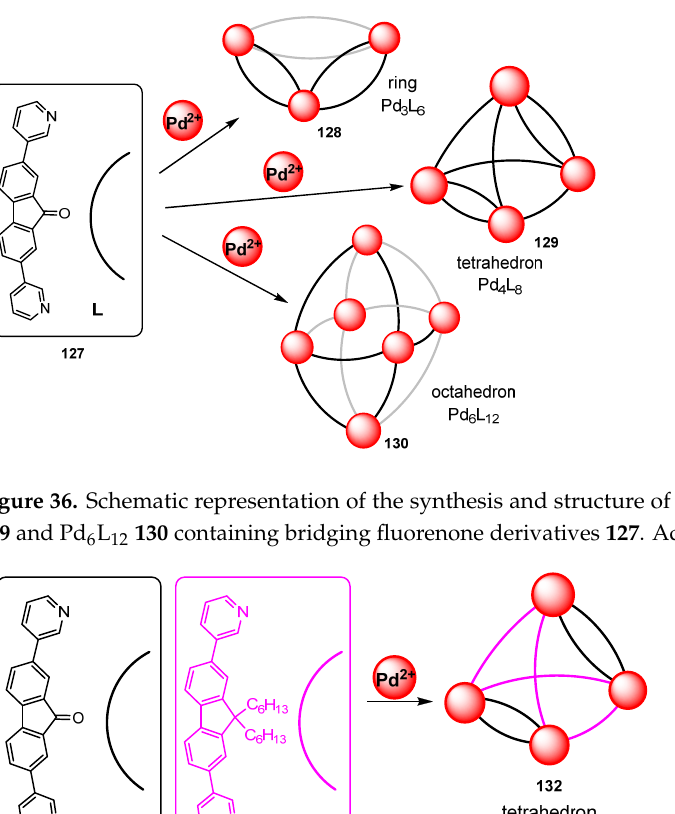
Figure 36. Schematic representation of the synthesis and structure of ring cages Pd 3 L 6 128 , Pd 4 L 8 129